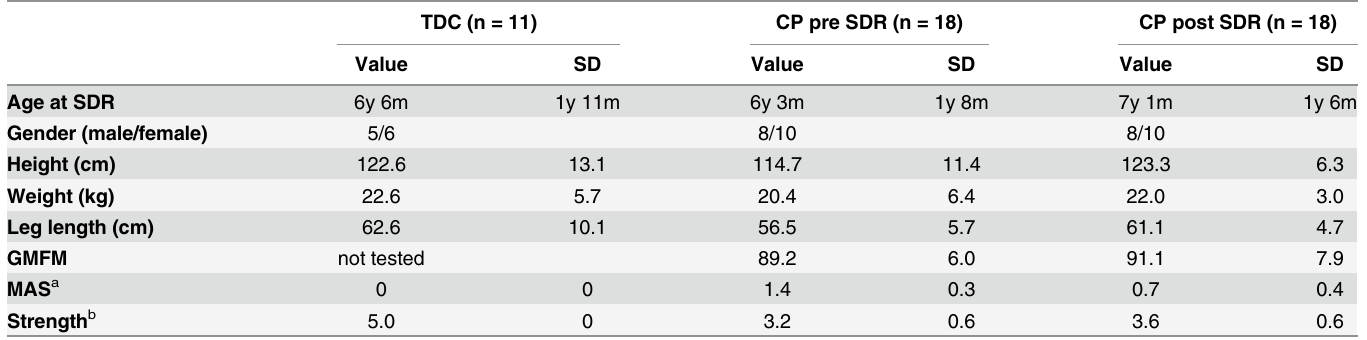
Table 1. CP children ’ s and TDC